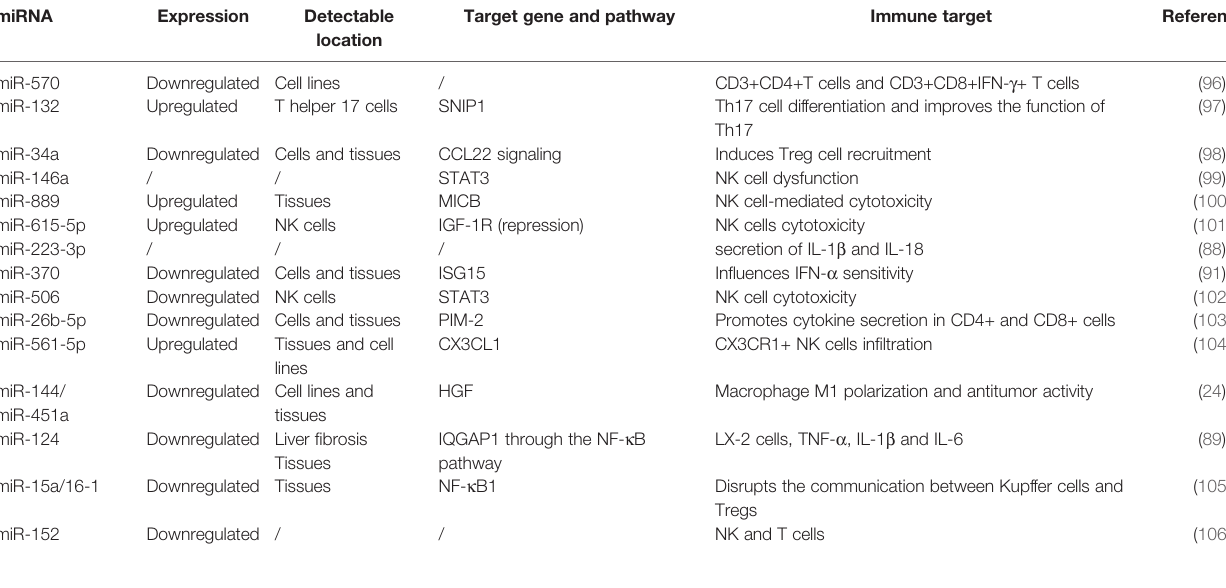
TABLE 4 | The abnormally expressed miRNAs involved in functional regulation of immune cells.